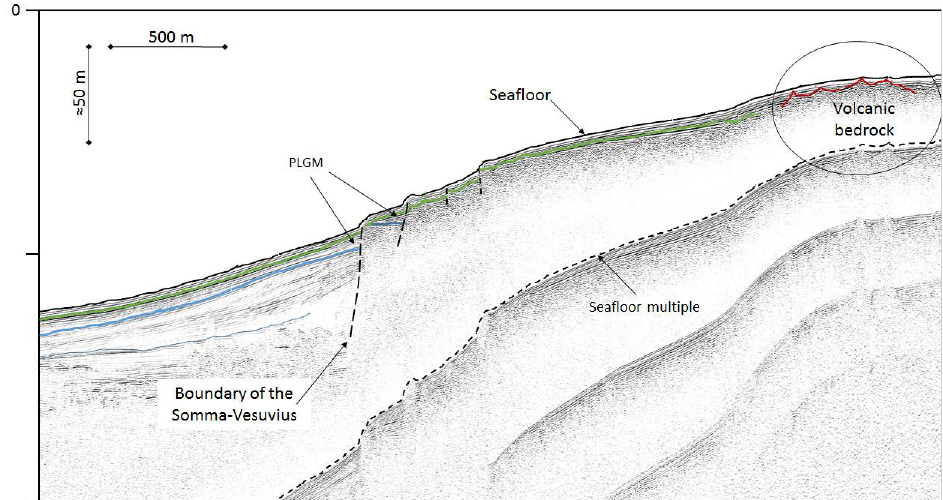
Figure 7. S3 Sparker mono-channel profile showing an example of stratigraphic correlation between volcanic bodies of the Somma-Vesuvius offshore and the distal boundary of the volcanic complex. Tephra layers often correlate with dark reflectors within the post-Last Glacial Maximum (PLGM) succession. Navigation line is in Figure 1. Modified after Paoletti et al. [25].